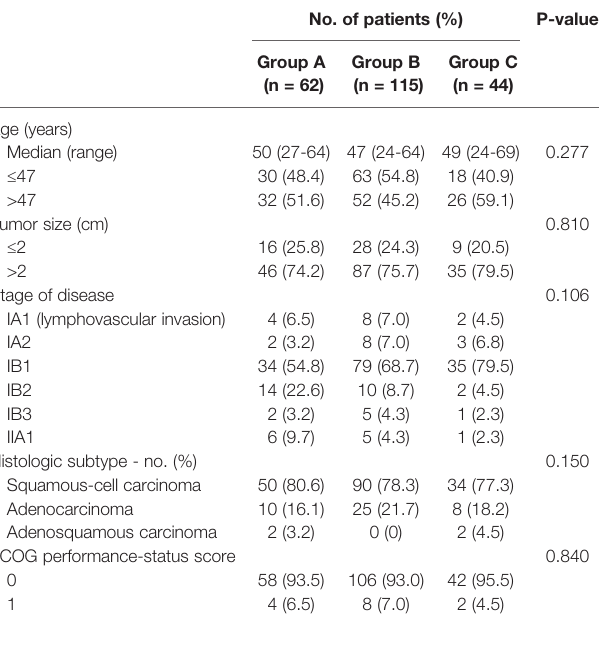
TABLE 1 | Baseline characteristics of patients.